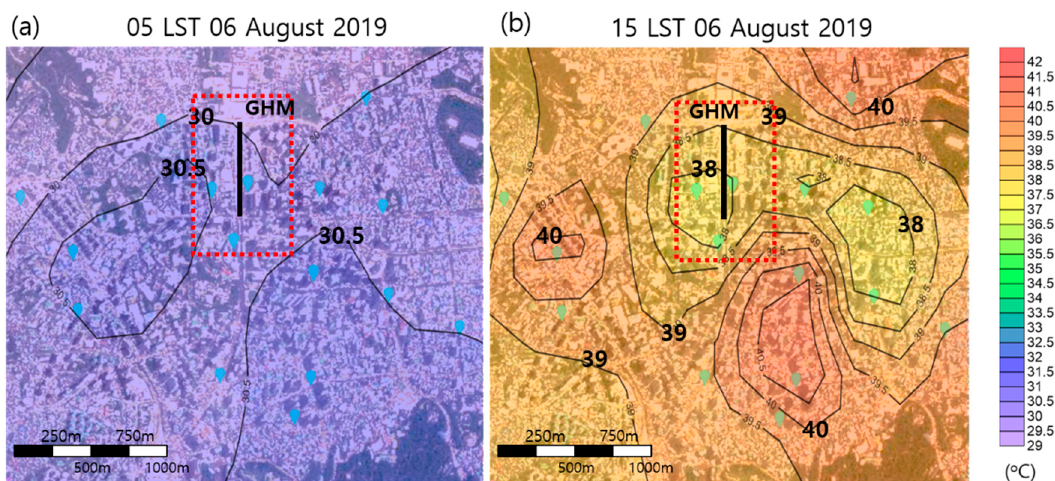
Figure 5. Horizontal distribution of air temperature obtained by kt automatic weather system (AWS) sensor network (indicated by light-blue or light-green symbols) at ( a ) 0500 LST and ( b ) 1500 LST on 6 August 2019. Open red dotted rectangle and closed black rectangle indicate the BBMEX campaign domain and the Gwanghwamun Square, respectively.